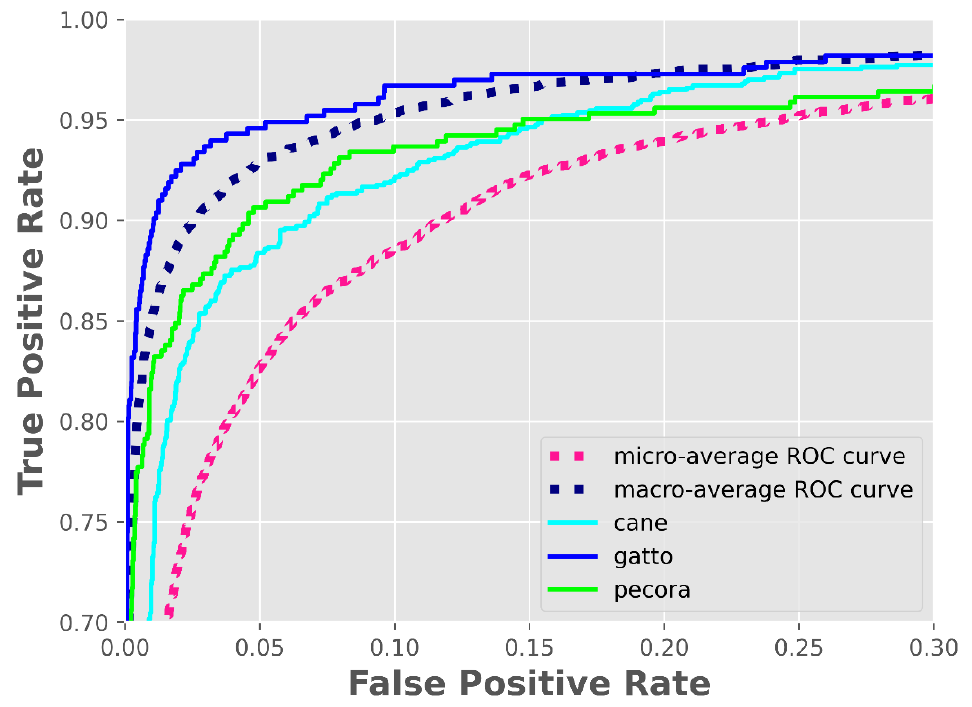
Figure 10. ROC curve of CASVM (ResNet18).